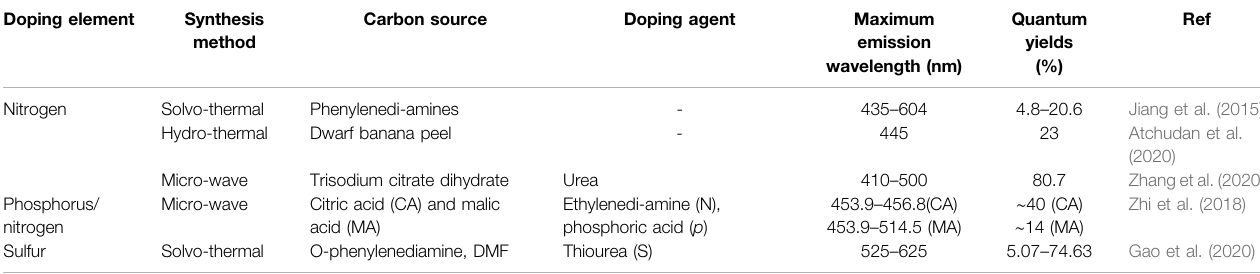
TABLE 3 | C-Dots doped with different element and their maximum emission